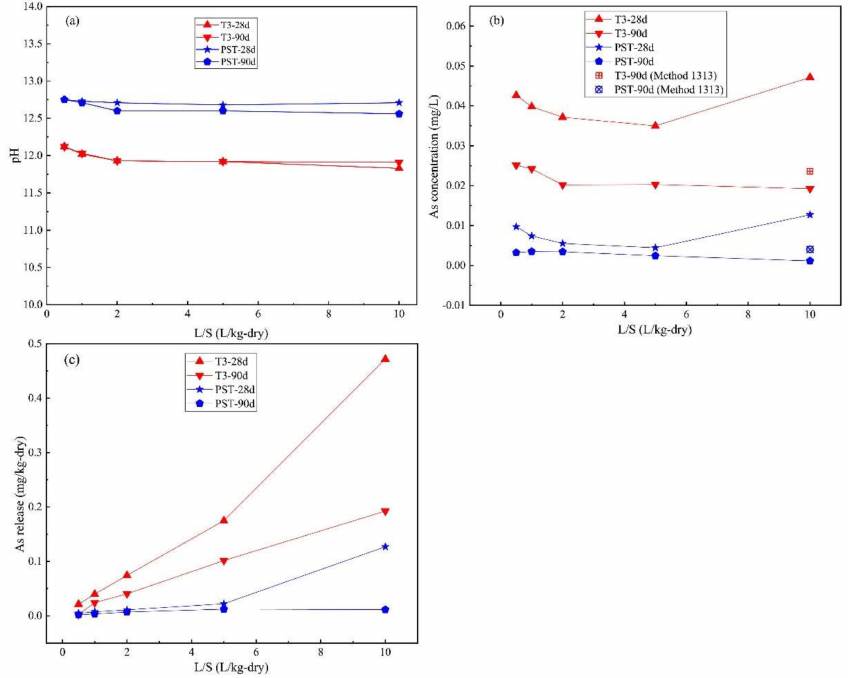
Figure 4. Method 1316 results for ( a ) pH; ( b ) As concentration; ( c ) As release from T3 and PST at curing for 28 d and 90